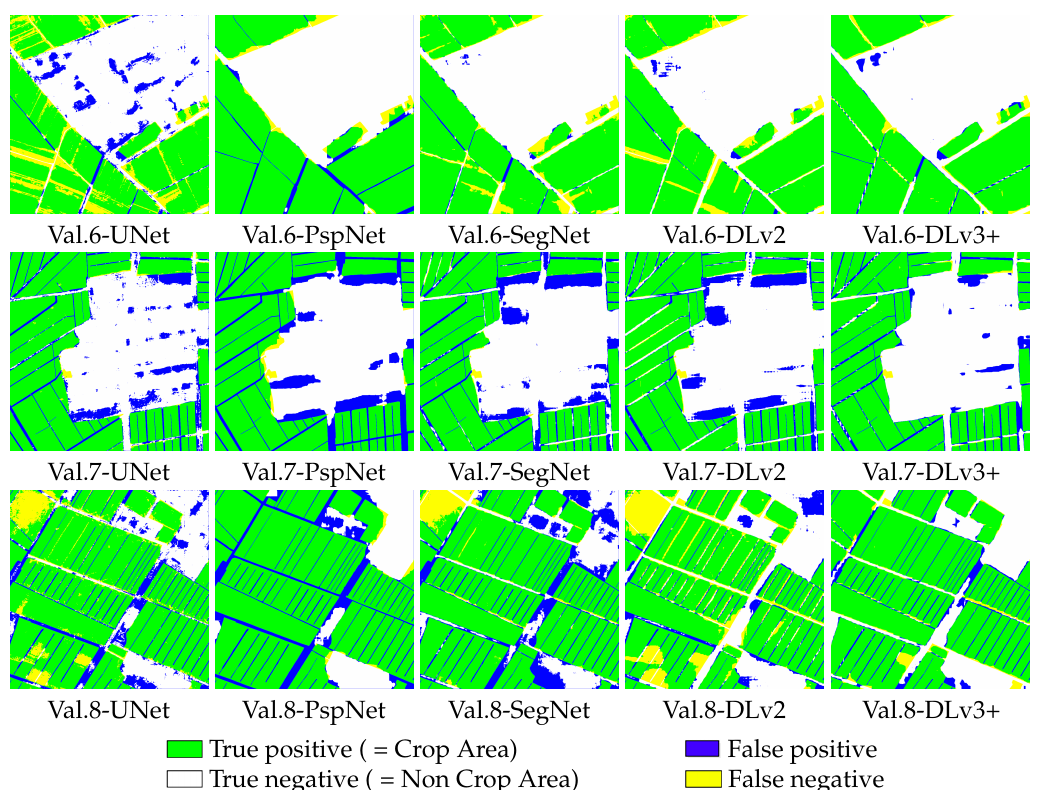
Figure 6. Classification maps for U-Net (UNet), PspNet, SegNet, DeepLabv2 (DLv2), and DeepLabv3+ (DLv3+) on eight validation slices.